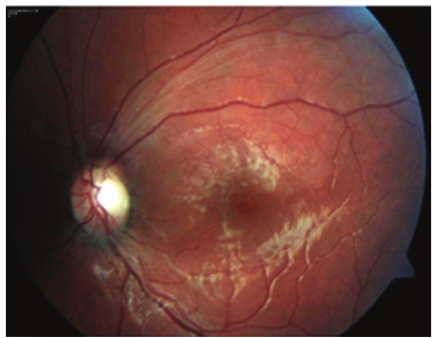
Figure 4: Improvement of retinal edema 20 days later.